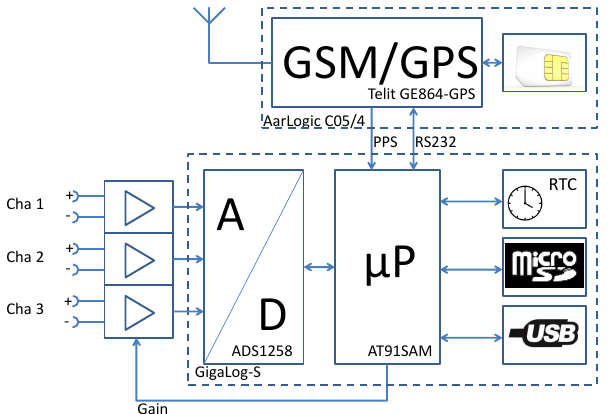
Figure 1. Block diagram of datalogger consisting of a GigaLog-S data acquisition module, a combined GSM/GPS modem and three preamplifiers. Figure 2. Datalogger system with datalogger, GSM/GPS antenna